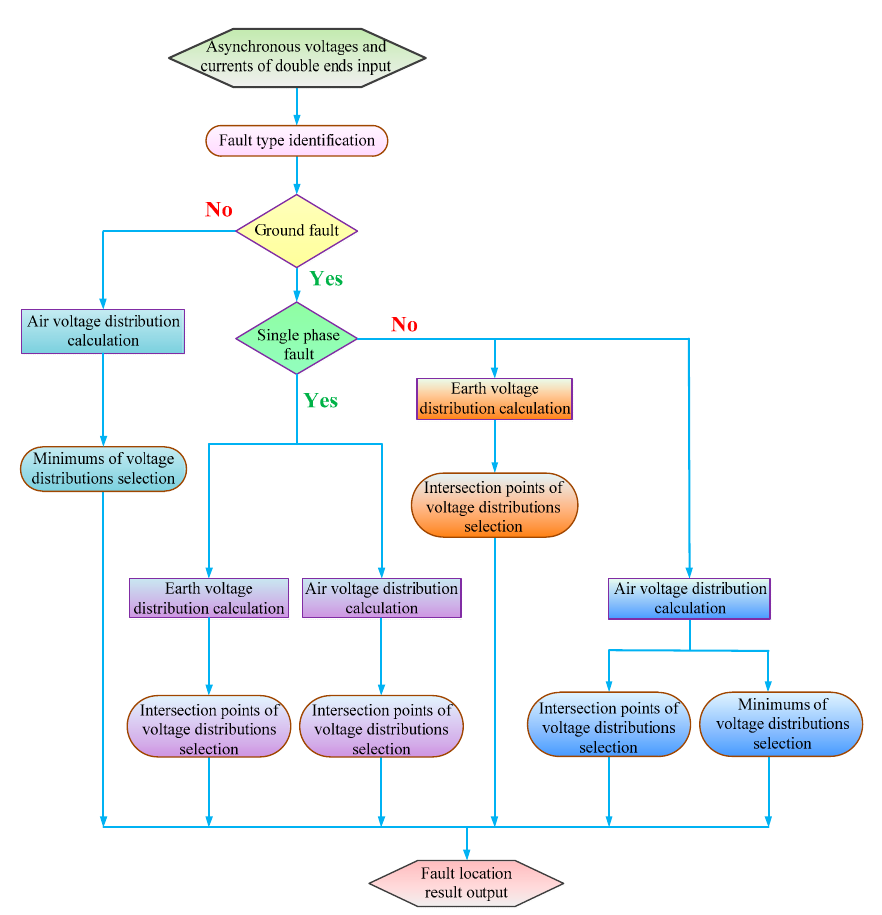
Figure 4. Overall flowchart of the modal voltage distribution based asynchronous double-end fault location (MVD-ADFL) method.